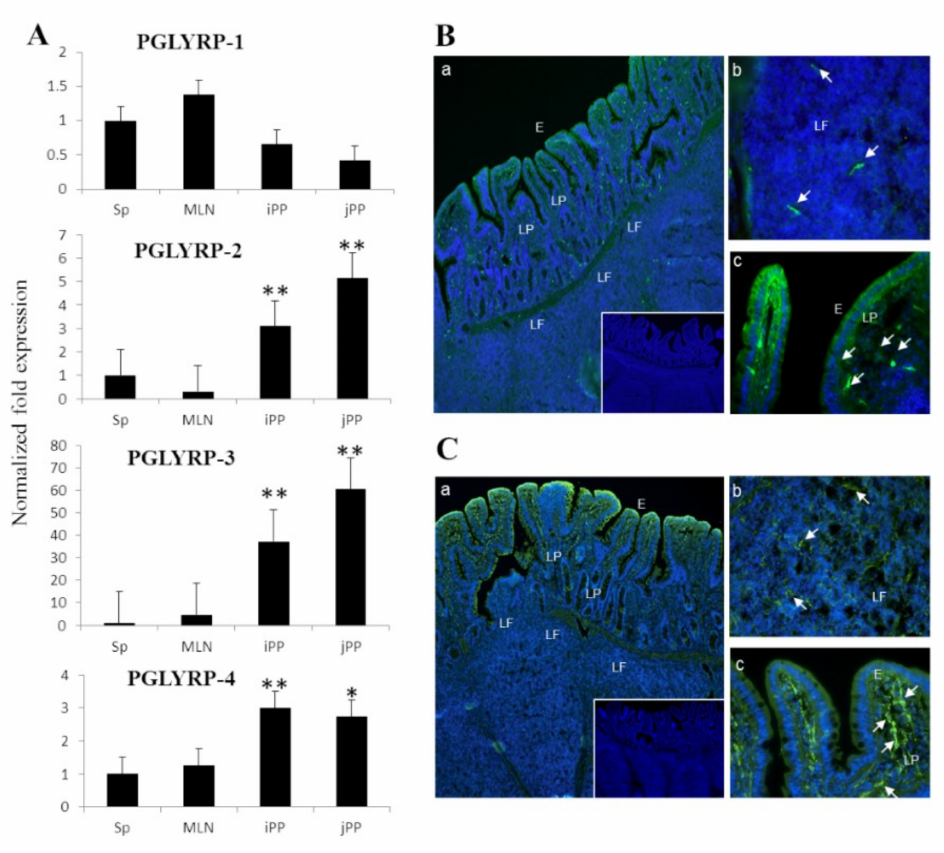
Figure 1. Expression analysis of peptidoglycan recognition proteins (PGLYRPs) in porcine tissues. PGLYRPs expression in the porcine spleen (Sp), mesenteric lymphoid nodes (MLN), and Peyer´s patches from the ileum (iPP) or jejunum (jPP) analyzed by real-time quantitative PCR ( A ). The PGLYRP mRNA expression level was normalized by using porcine β -actin mRNA and the relative index was determined by comparison to the PGLYRP mRNA level in the spleen (1.00). Immunohistochemical analysis of PGLYRP-3 ( B ) and PGLYRP-4 ( C ) expressions are displayed for ileal Peyer’s patches. Images represent the expression of PGLYRPs in the whole iPP (a), in the lymphoid follicles of iPP (b), and in the lymphoid follicle epithelium of iPP (c). The arrow indicates the presence of dendritic-like cells with a strong expression of PGLYRP-3 or PGLYRP-4. E: epithelium, LP: lamina propria, LF: lymphoid follicle. Values represent the means and error bars indicate the standard deviation. The results are shown as means ± standard deviation obtained from three independent experiments ( n = 6). * p < 0.05, ** p < 0.01 against